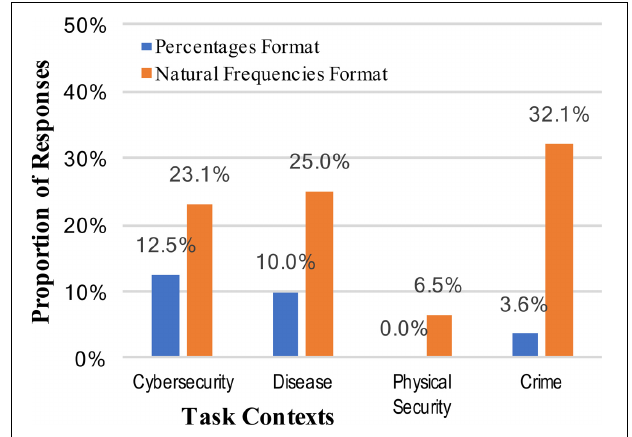
FIGURE 1 | Percentages of participants who reached the correct posterior probability answer to the Bayesian reasoning task, across the context stories and numerical format